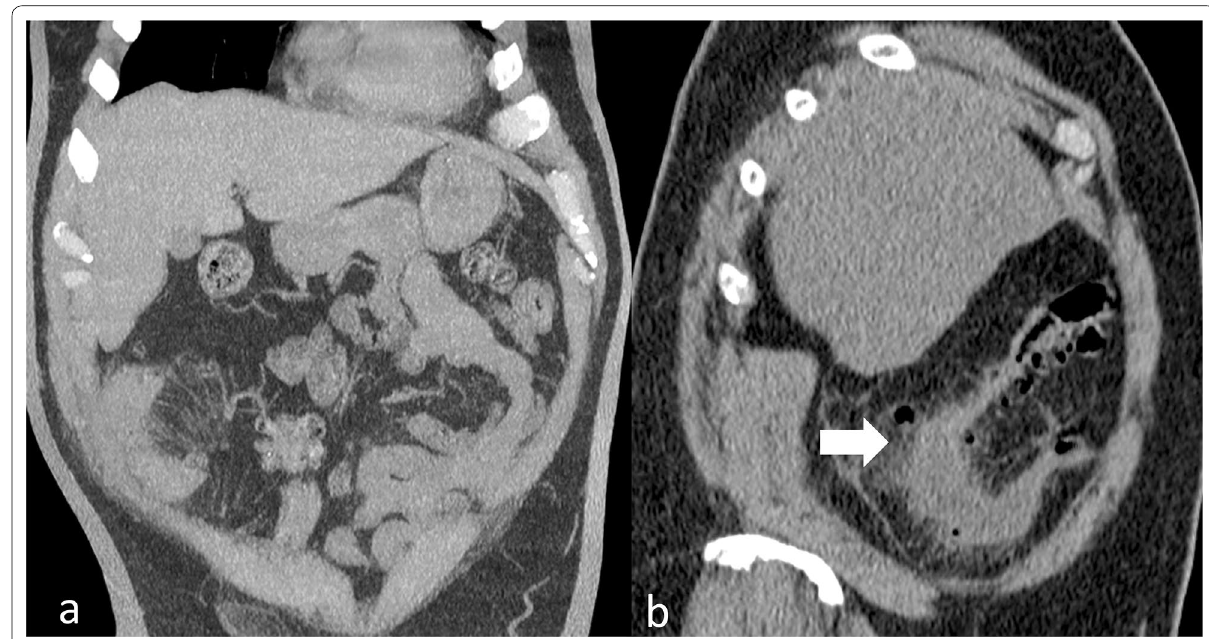
Fig. 2 The CT scan of the abdomen and pelvis without intravenous contrast material. In a , the coronal reformat and in b the sagittal reformat. The scan showed the wall thickening of the left and sigmoid colon, with diverticular outpouching. Moreover, there was stranding of the perivisceral fat due to perivisceral tissue inflammation complicated with limited perforation and a small free air pocket next it; therefore, the diagnosis favoured was diverticulitis with limited perforation (white arrow). There was no free